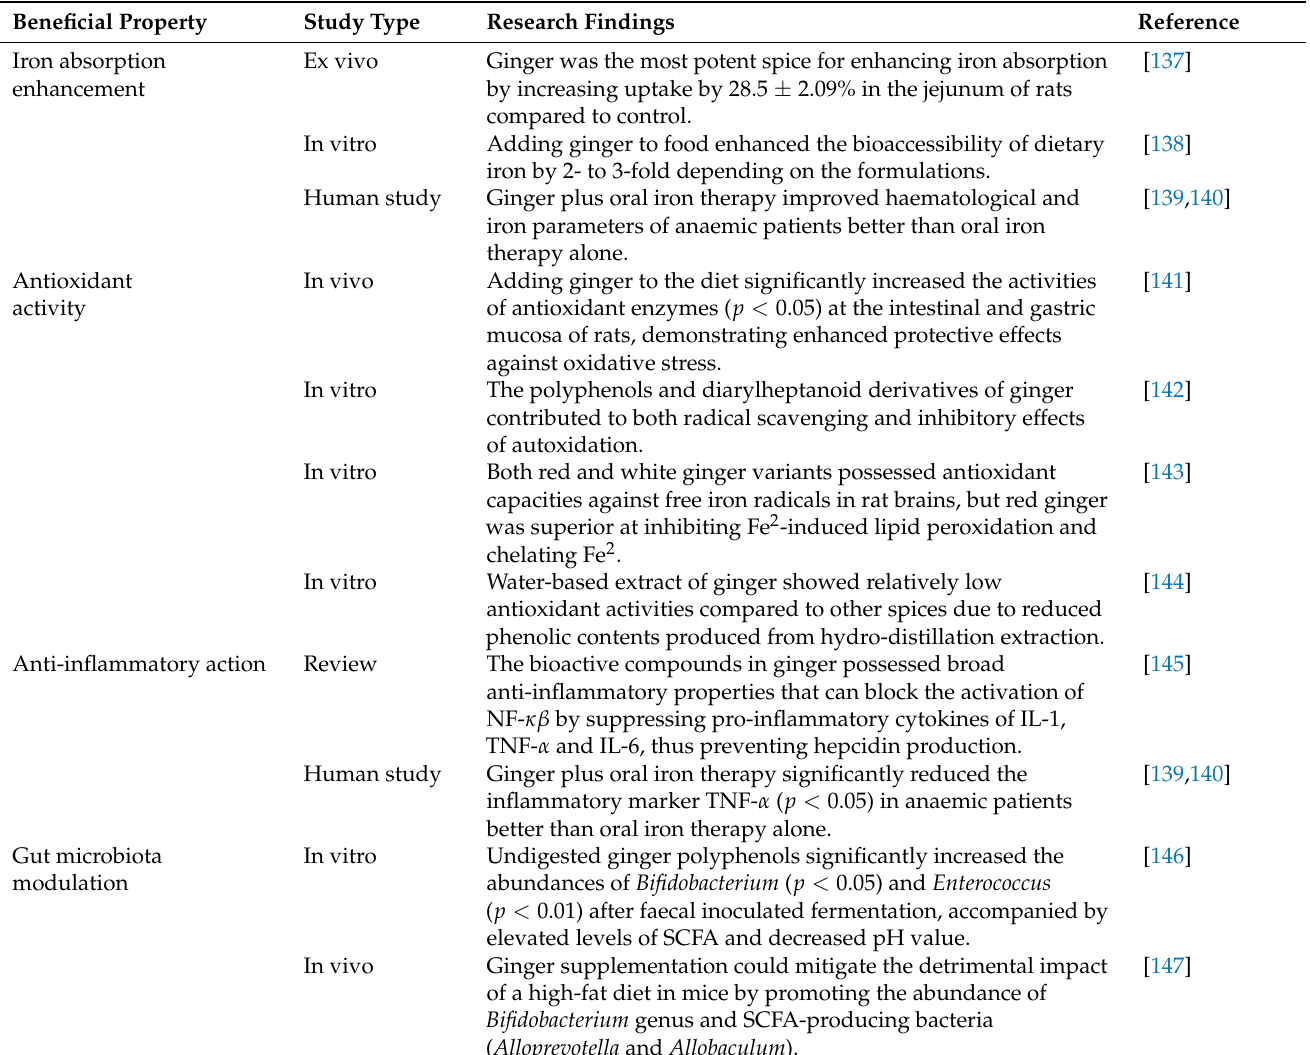
Table 2. A summary of the research findings on ginger’s beneficial properties in its applications for iron deficiency anaemia and associated clinical manifestations of altered iron